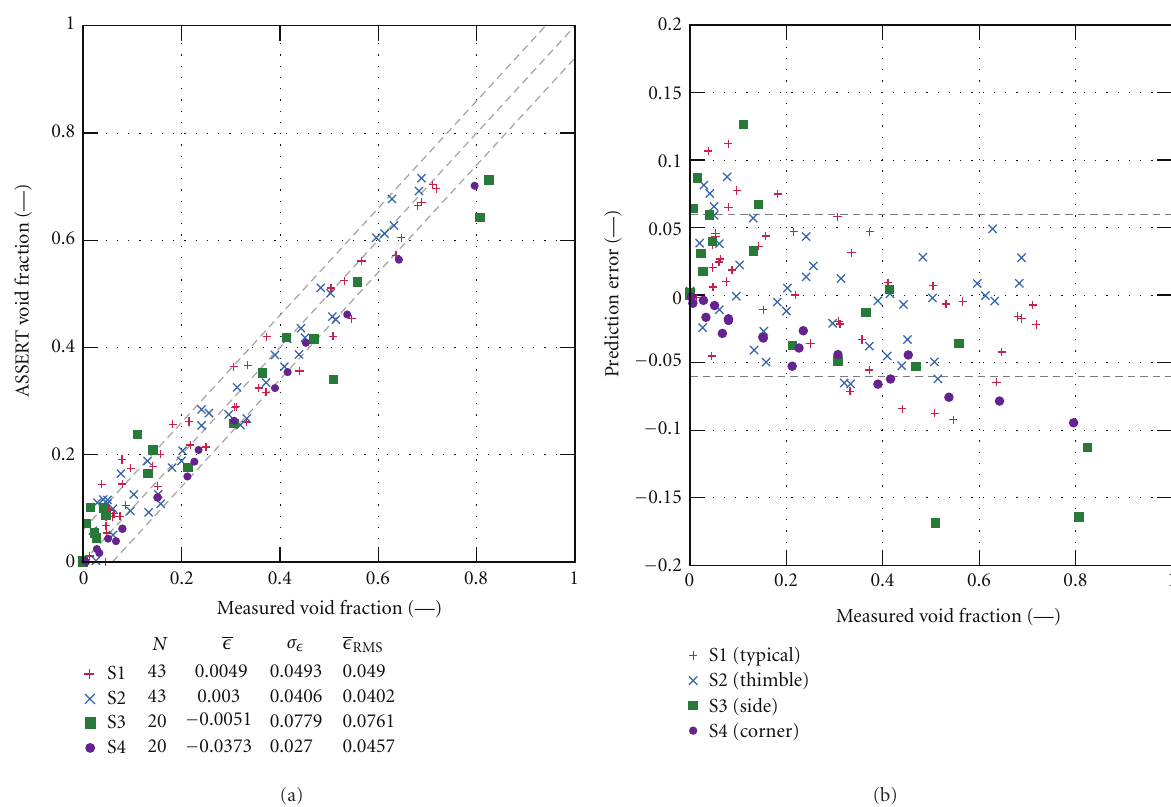
Figure 7: Code accuracy in predicting void fraction in a single isolated subchannel. Predicted versus measured results (a) and error versus measured void fraction (b). Error bands displayed correspond to 2 σ = 0 . 06.